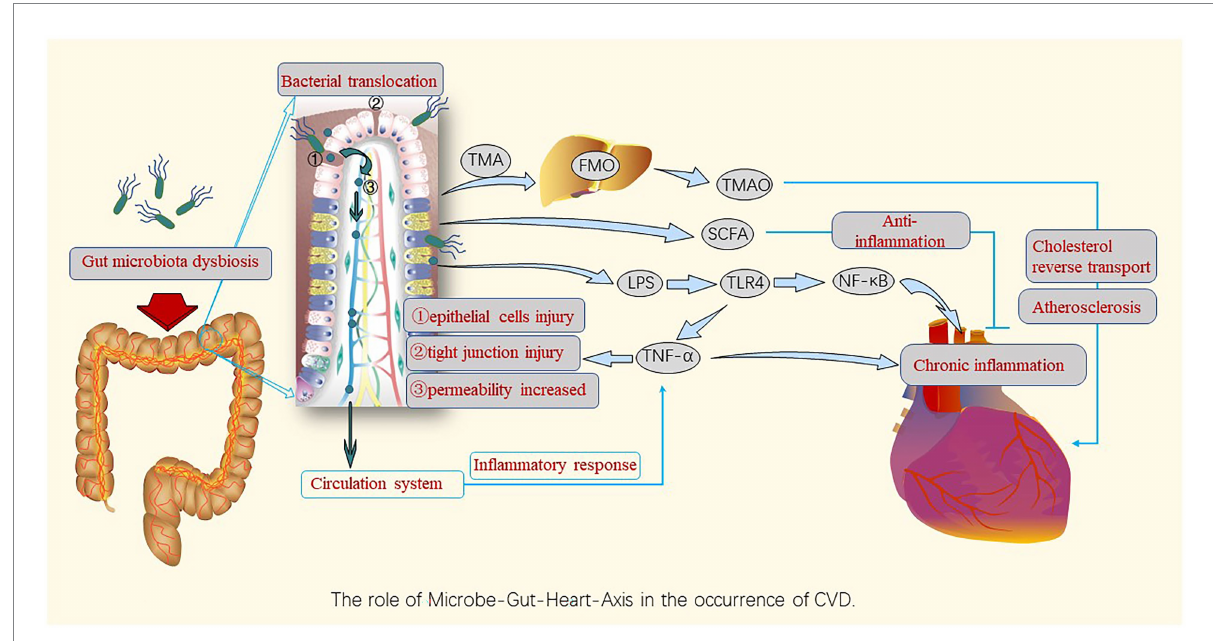
FIGURE 2 Roles of gut microbiota dysbiosis and bacterial translocation in the occurrence and development of CVDs. Gut microbiota dysbiosis destroys the barrier function, leading to gut bacteria leakage, entry of bacterial components into the circulatory system, and induction of chronic inflammation by harmful metabolites such as TMAO and pro-inflammatory factors, causing harm to the cardiovascular system via the gut-heart axis; however, SCFAs play an anti-inflammatory role in this axis. TMA, trimethylamine; FMO, flavin-containing monooxygenase; TMAO, Trimethylamine N-oxide; SCFAs, short-chain fatty acids; LPS, lipopolysaccharides; TLR-4,Toll-like receptor-4; NF- κ B, nuclear factor kappa B; TNF, tumor necrosis